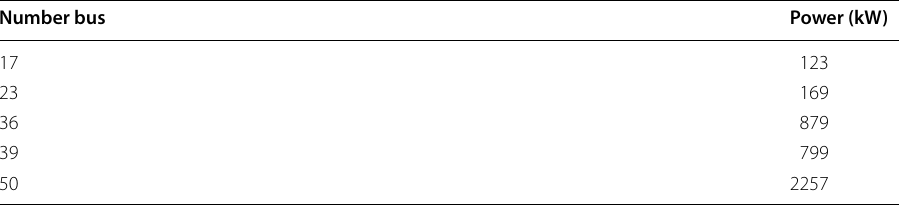
Table 5 Parameters of placement and sizing under the output power factor of 0.85, post-phase in the 69-bus